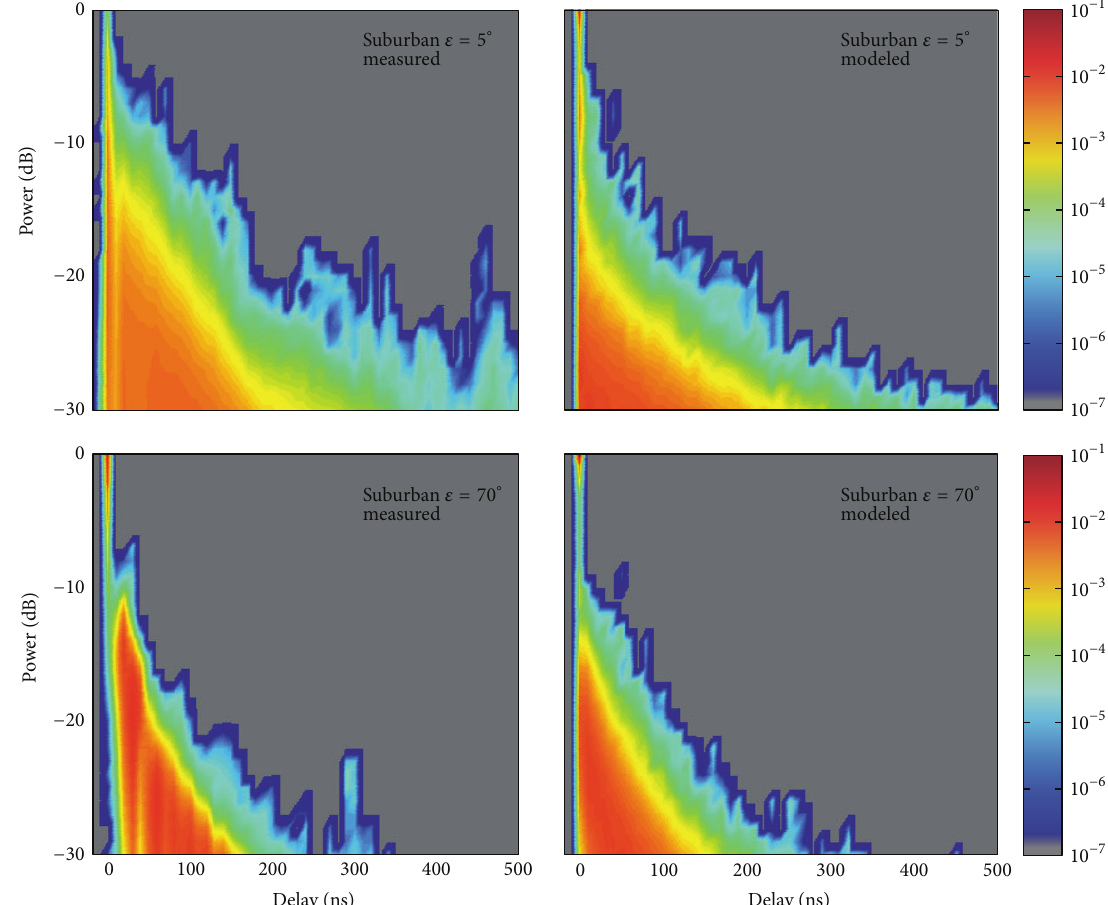
Figure 26: Comparison of the probability density function of the expected value of coexisting echoes in the measured and modeled suburban car environment at 5 ∘ and 70 ∘ elevation,